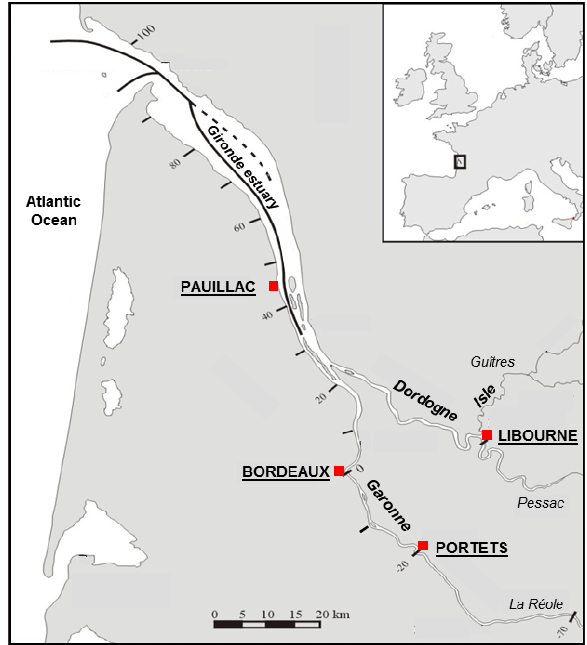
Fig. 1. Location map of the Gironde fluvial-estuarine system show-